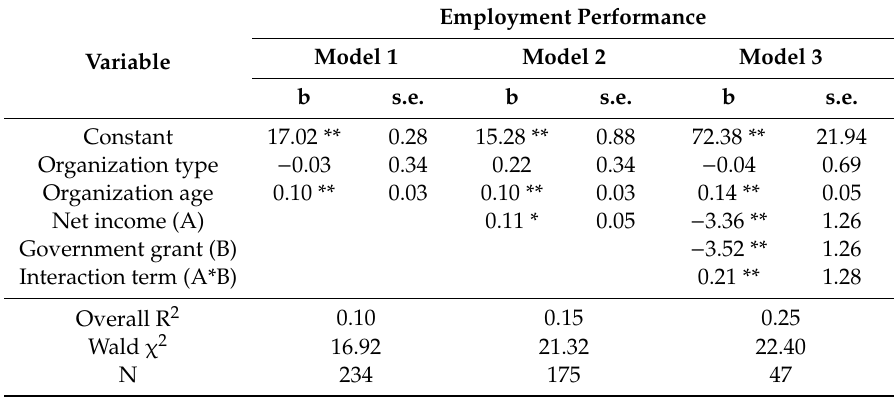
Table 3. Panel analysis: employment performance, net income and government grants.